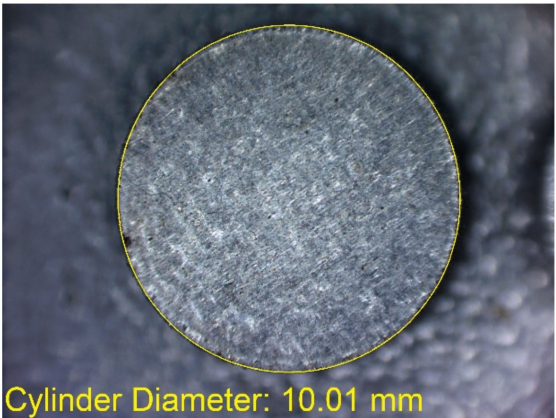
Figure 10. Measurement result for cylindrical holes and solids made in the DMLS technology: cylinder with a nominal diameter D d = Ø10 mm (D d1 = 10.01